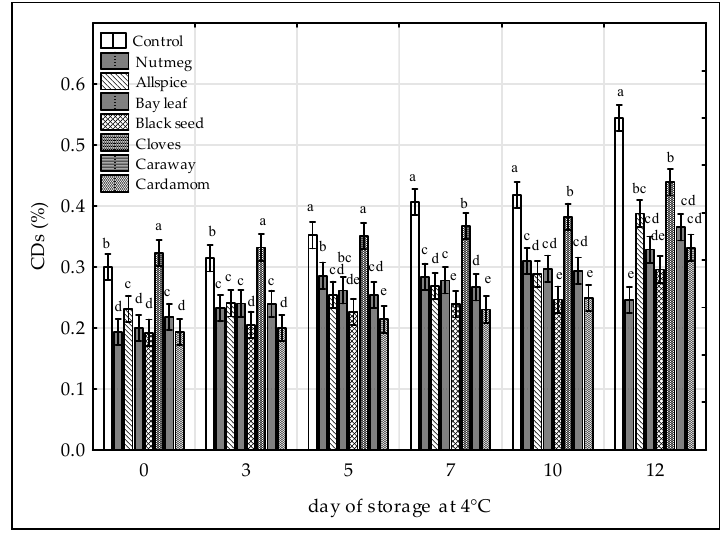
Figure 1. Effect of various spice extract treatments on conjugated dienes (CDs) in raw ground chicken legs during 12 days of storage at 4 °C. Means with the various superscript within the same day are significantly different ( p ≤ 0.05, Duncan’s test). Vertical bars indicate 0.95 confidence intervals.